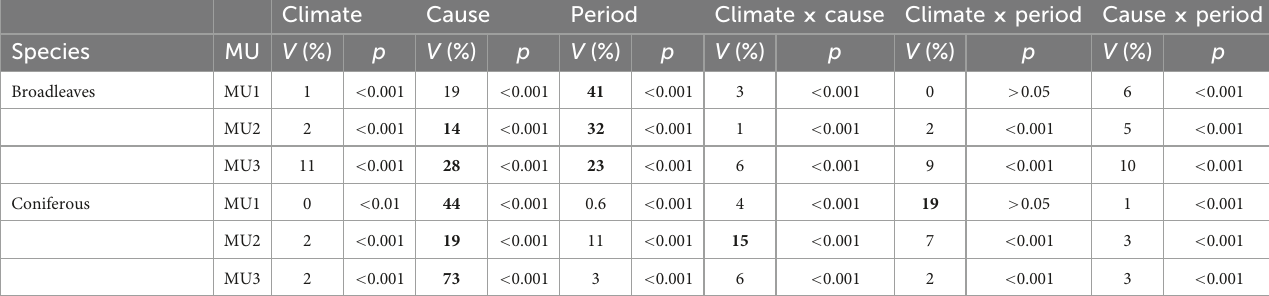
TABLE 4 Variation explained ( V ) and significance of the effects of climate, mortality cause (competitive exclusion vs. wildfires), period (succession), and the interaction of climate × cause in the three MU from 2010 to